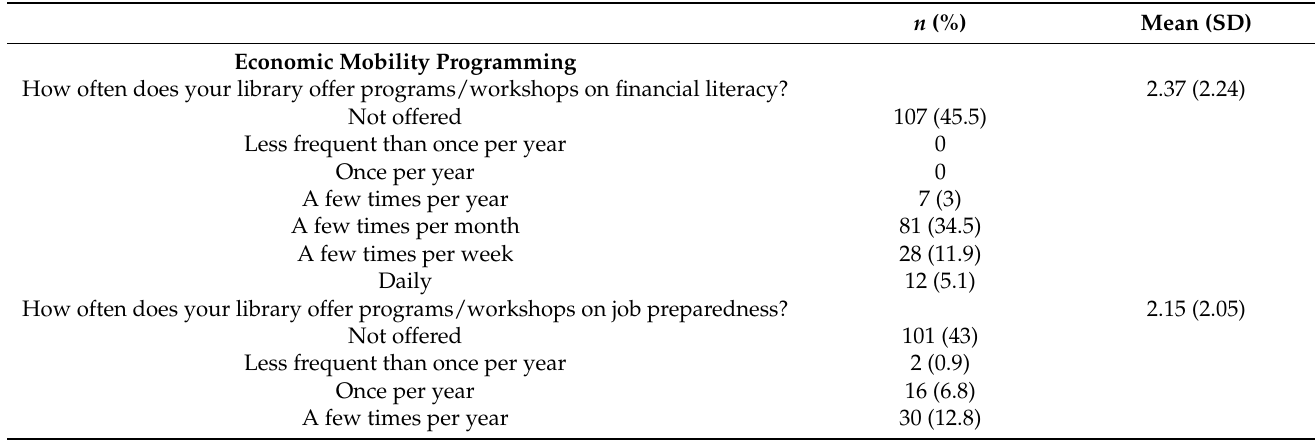
Table 2. Descriptives of Programming for Libraries Surveyed ( n =